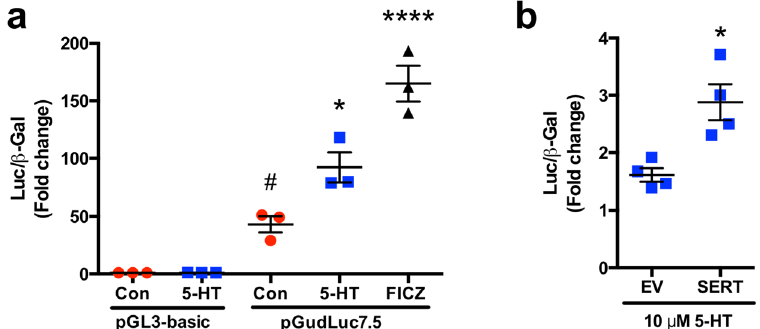
Figure 5. 5-HT induces XRE reporter activity in a SERT-dependent manner. Caco-2 cells were treated beginning 24 h post-transfection. ( a ) Caco-2 cells were transiently co-transfected with pGudLuc7.5 luciferase XRE-reporter or pGL3-basic along with a β -gal mammalian expression plasmid (CMV- β ) by lipofectamine. Cells were treated with 5-HT (10 μ M), AhR ligand 6-formylindolo[3,2 b ]carbazole (FICZ) (10 nM), or vehicle (Con) for 24 h in serum-free medium. Reporter activity was measured by luciferase assay. Assays were performed using quadruplicate wells for each treatment and values were normalized to β -gal activity. Results are expressed as fold-change activity of untreated (Con) pGL3-basic transfected cells. Data analyzed by 1-way ANOVA followed by Tukey’s multiple comparisons test ( n = 3). * P < 0.05, **** P < 0.0001 vs. untreated cells transfected with pGudLuc7.5 ## P < 0.05 vs. pGL3-basic. ( b ) Caco-2 cells were transiently co-transfected with pGudLuc7.5 Luciferase XRE-reporter, CMV- β , and either a SERT overexpression vector or empty vector (EV) by Amaxa electroporation. Cells were treated with 5-HT (10 μ M) for 24 h in serum-free medium. Reporter activity was measured by luciferase assay. Assays were performed using quadruplicate wells for each treatment and values were normalized to β -gal. Results are expressed as fold-change over the activity of untreated cells. Data analyzed by unpaired 2-tailed Student’s t -test ( n = 4). * P < 0.05 vs. EV. Red circle = untreated, blue square = 5-HT, black diamond = FICZ.